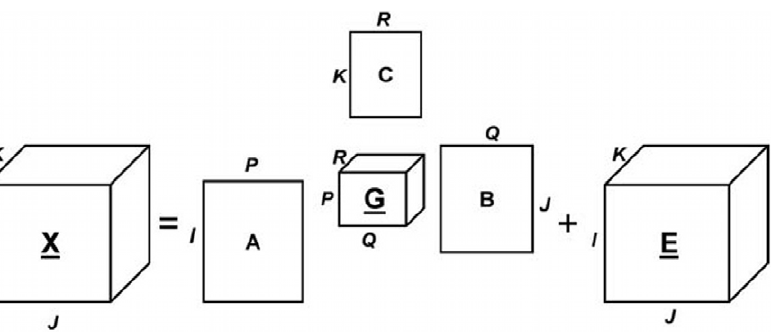
Figure 7. Illustration of a Tucker3 model for tensor analysis. P , Q and R indicate the number of components extracted from the first, second and third mode ( P ƒ I , Q ƒ J , R ƒ K ), respectively, and A [ < I | P , B [ < J | Q and C [ < K | R are the component matrices. G [ < P | Q | R is the core tensor and E [ < I | J | K represents the error term.